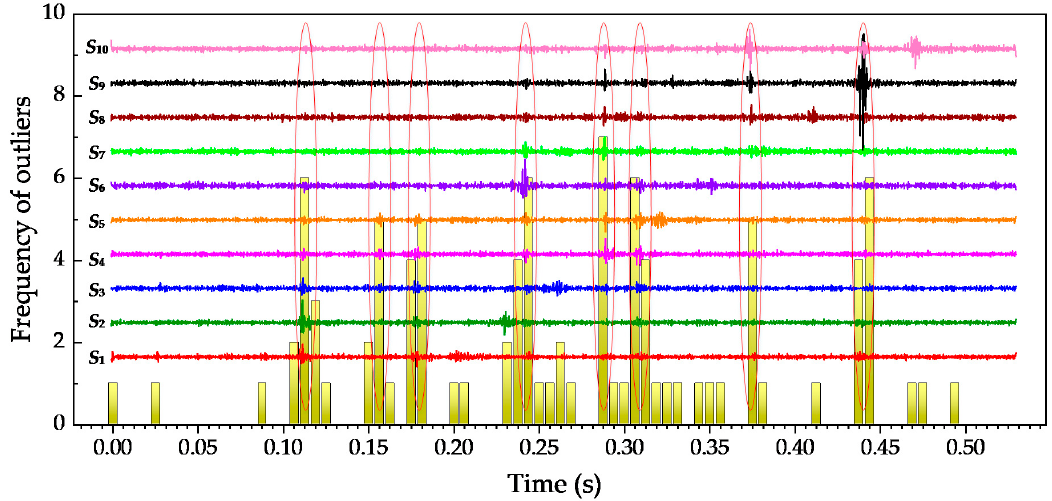
Figure 22. The filtered outputs and identified impact processes.